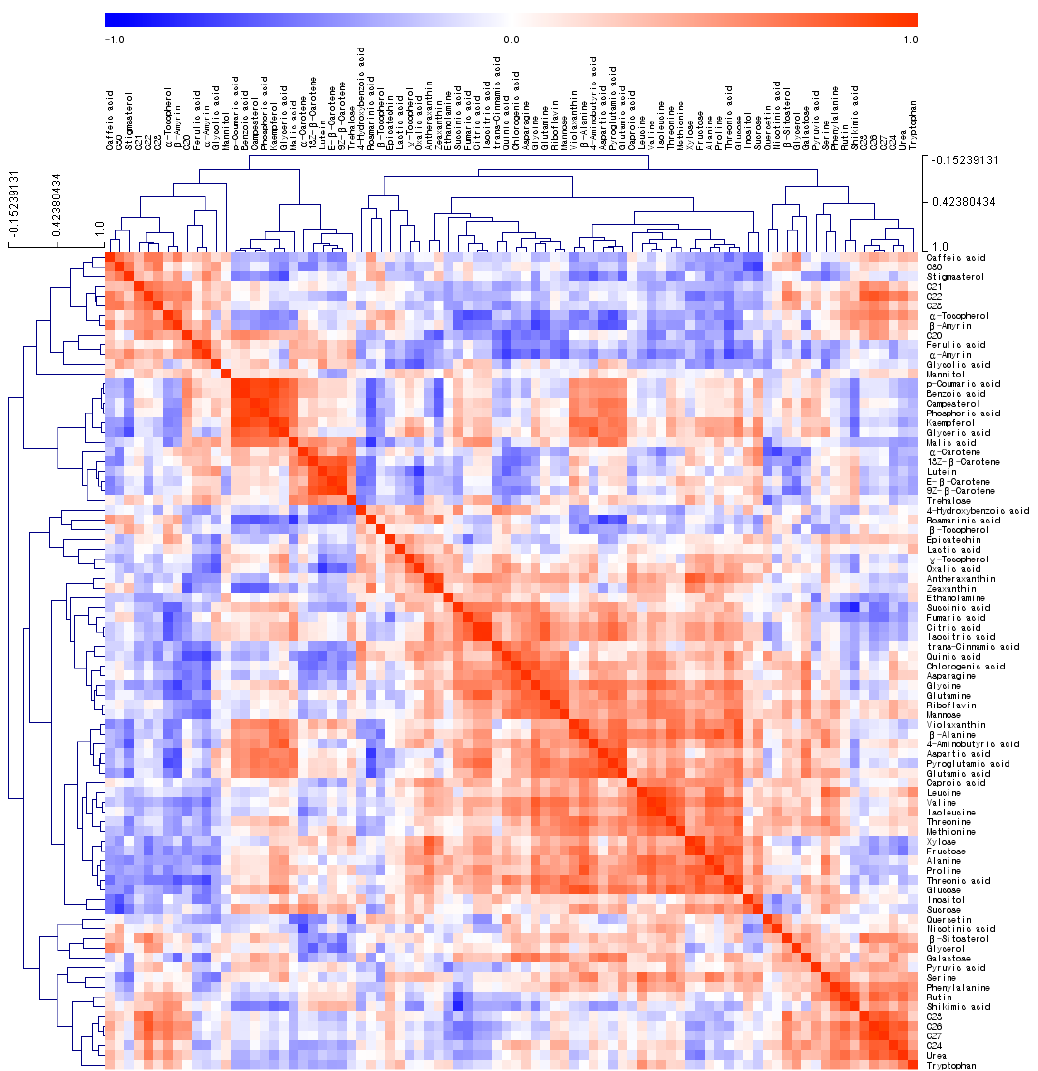
Figure 4. Hierarchical clustering analysis (HCA) of compound data from the nine Mentha spp. Each square indicates the Pearson’s correlation coefficient of a pair of compounds and the value of the correlation coefficient is represented by the intensity of blue or red colors, as indicated on the color scale. C20, eicosanol; C21, heneicosanol; C22, docosanol; C23, tricosanol; C24, tetracosanol; C26, hexacosanol; C27, heptacosanol; C28, octacosanol; C30, triacontanol.